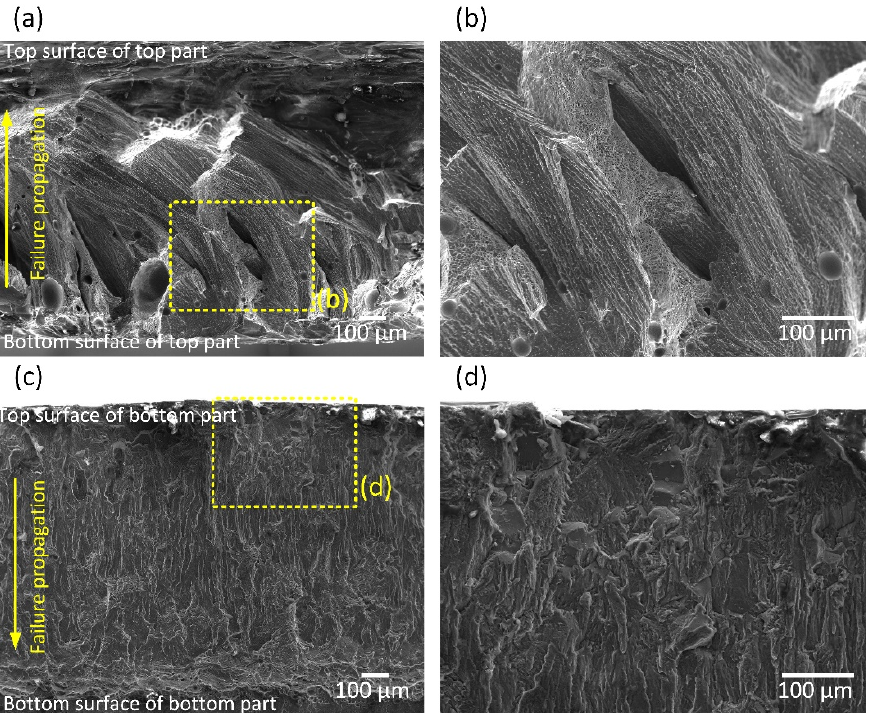
Figure 15. Representative fatigue fractography of ( a ) the fusion zone failure and ( c ) the weld root failure, with detailed views in ( b ) and ( d ).